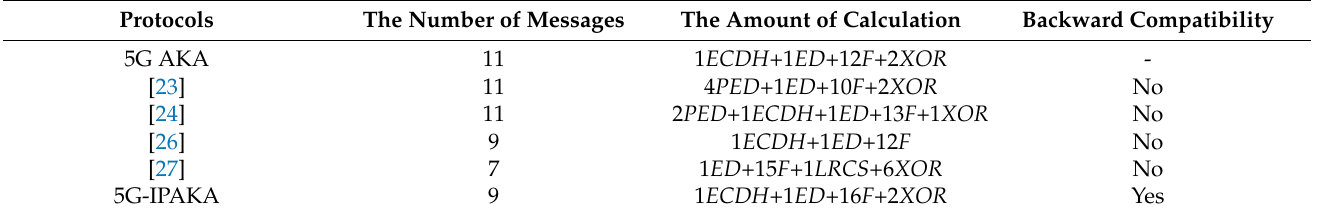
Table 2. A comparative analysis between the 5G-IPAKA protocol and the recently improved 5G AKA protocols [23,24,26,27] regarding the number of messages, the amount of calculation, and backward